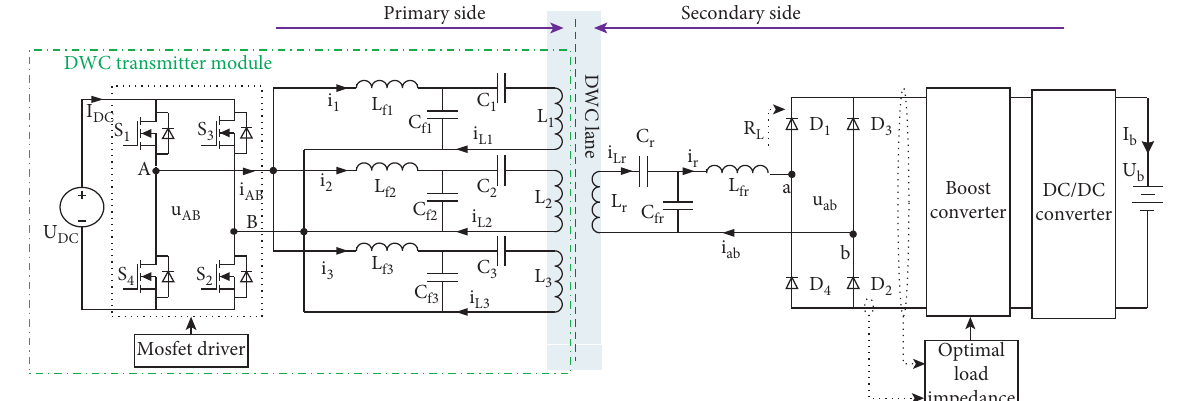
Figure 1: Structure diagram of the designed DWC system.